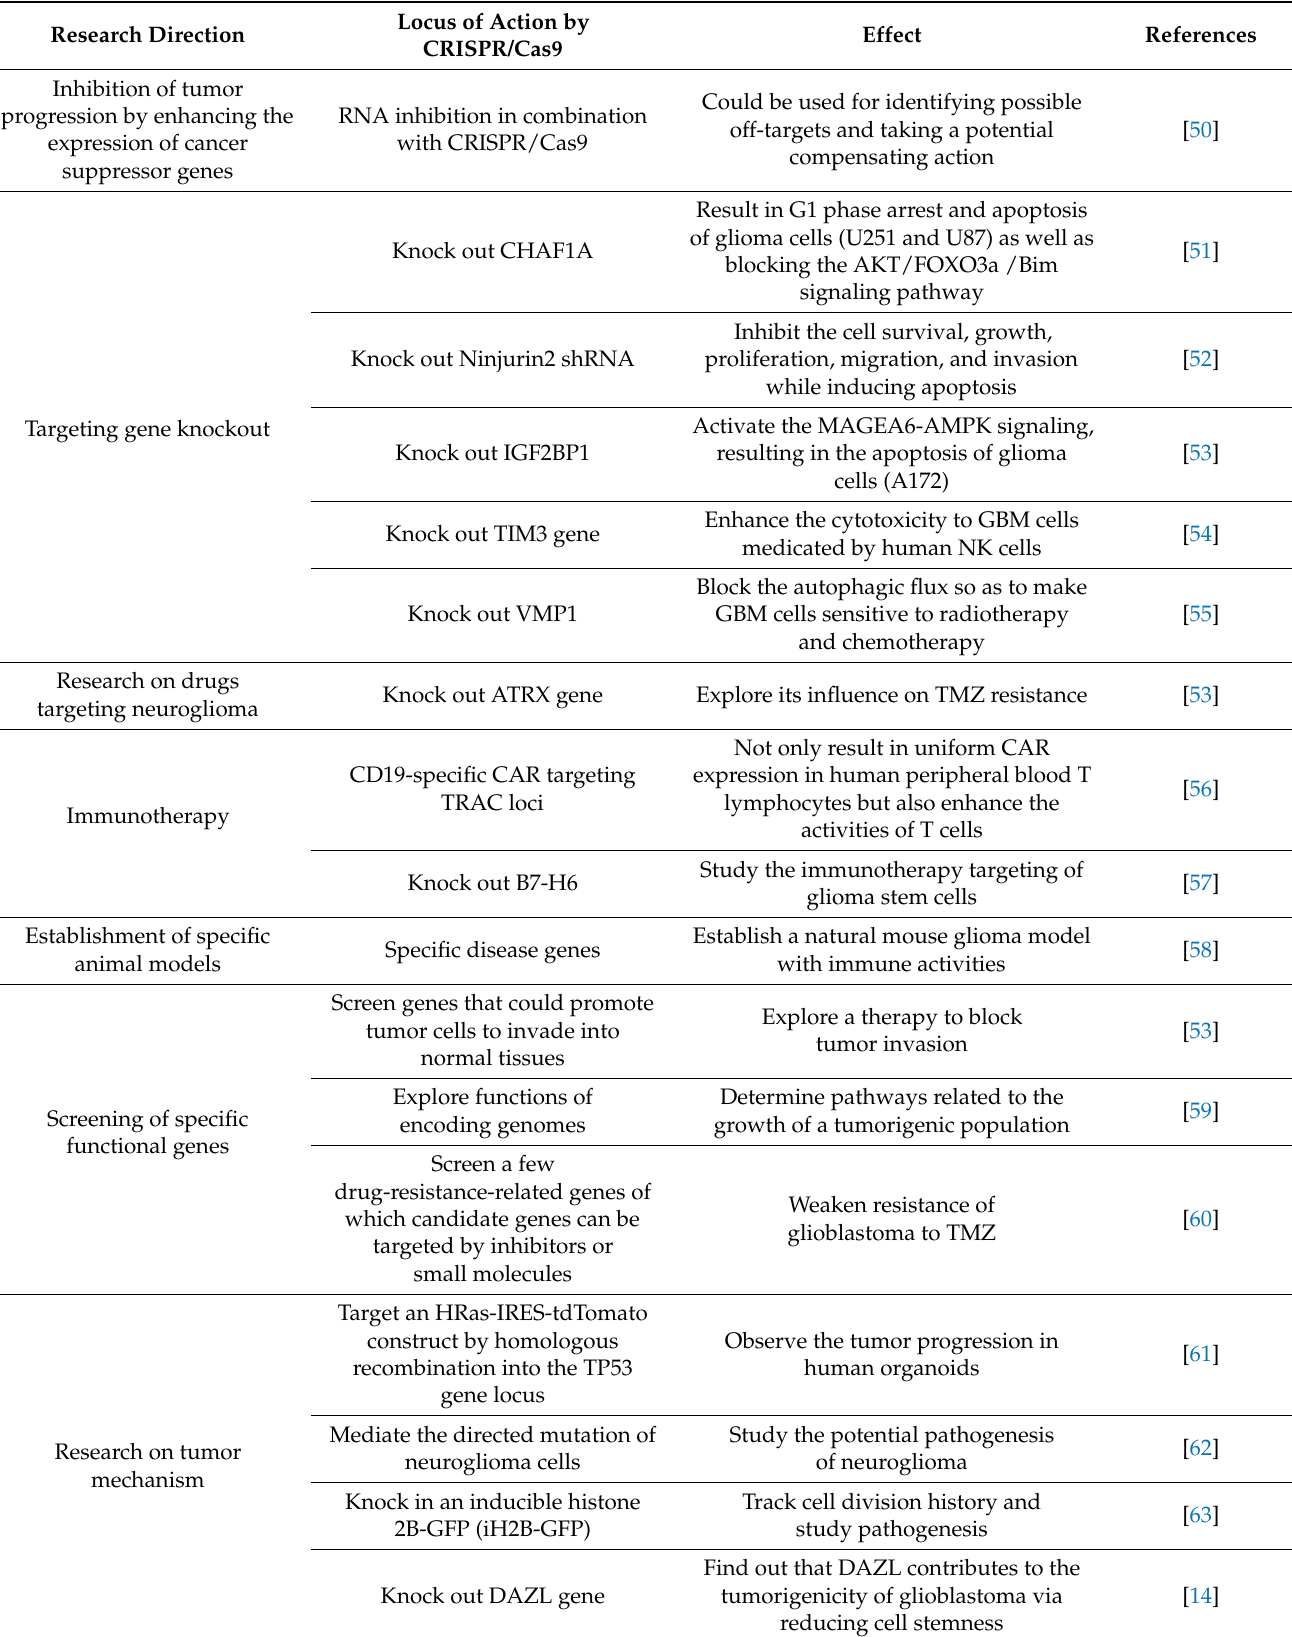
Table 2. Research on application of CRISPR/Cas9 in